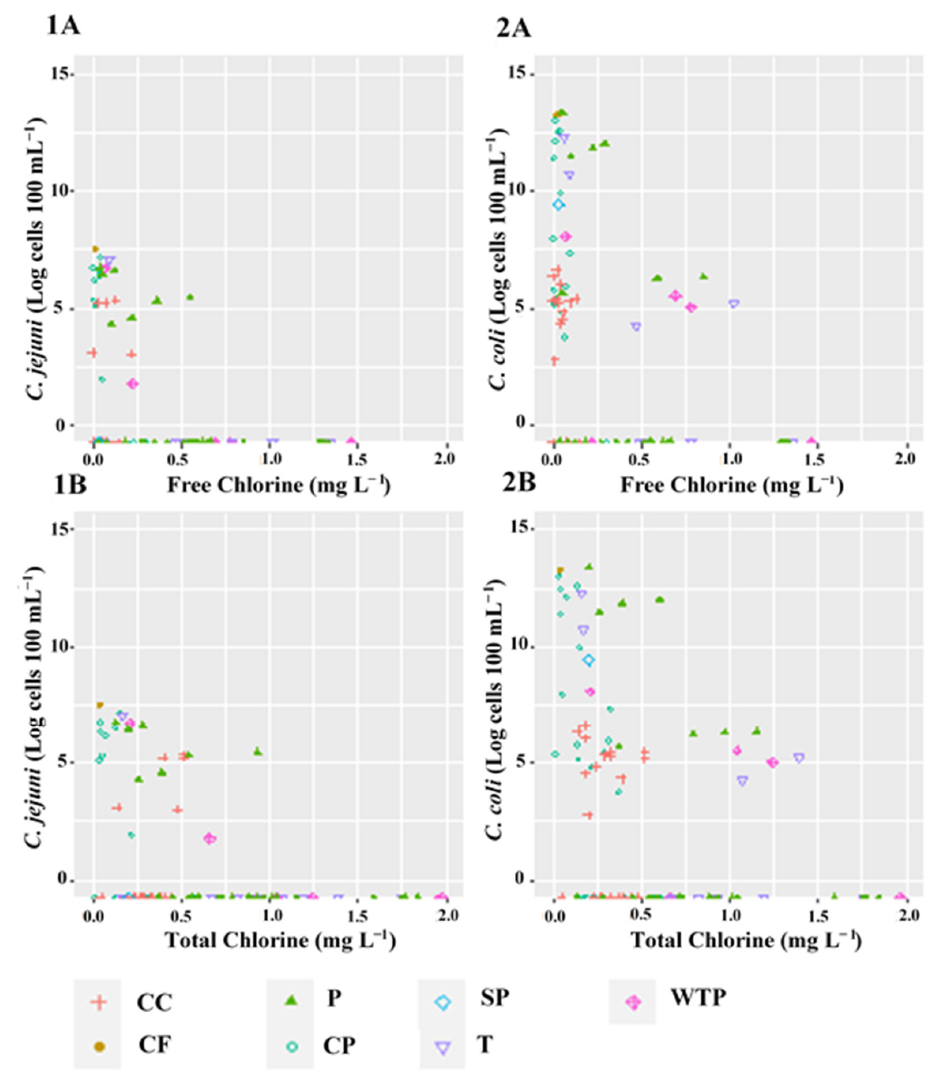
Figure 4. Correlation analysis between Campylobacter spp. and chlorine (free and total) across each sampling point: C. jejuni (panels: 1A and 1B ) and C. coli (panels: 2A and 2B ) vs. free and total chlorine.